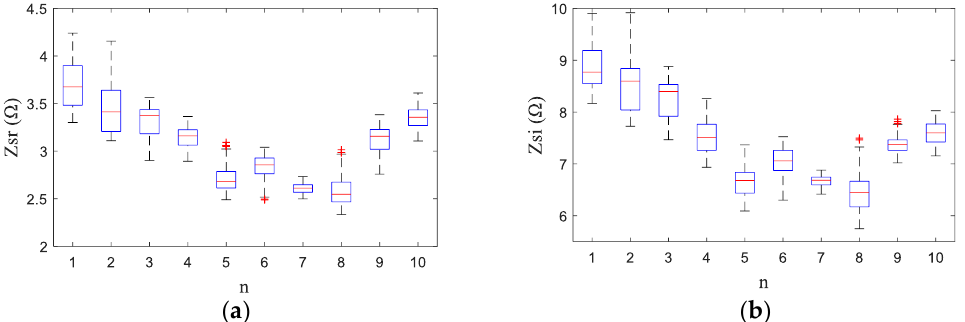
Figure 6. Results of method 3 in simulation I. ( a ) The result of the real part; ( b ) The result of the imaginary part.